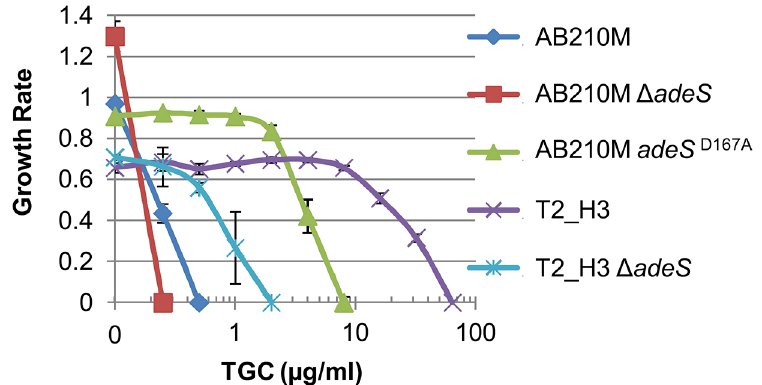
Fig 6. adeS mutations increase TGC MIC, but not to the level detected in bioreactor isolates. Strains were cultured in MHBII with increasing amounts of TGC to measure the growth rate. The MIC of each strain is the point where the growth rate equals 0. Error bars represent the 95% confidence